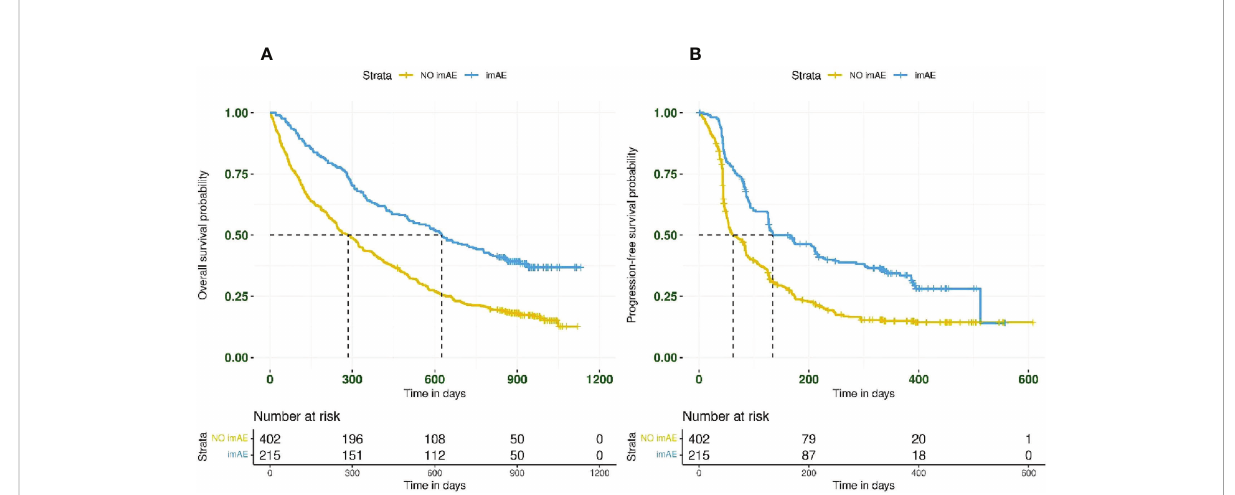
FIGURE 1 Kaplan – Meier plots for (A) overall survival and (B) progression-free survival by imAE development in patients treated with immunotherapy ( n = 617). Data from patients randomized to durvalumab ( n = 307) were combined with those from patients randomized to durvalumab plus tremelimumab ( n = 310). imAE, immune-mediated adverse